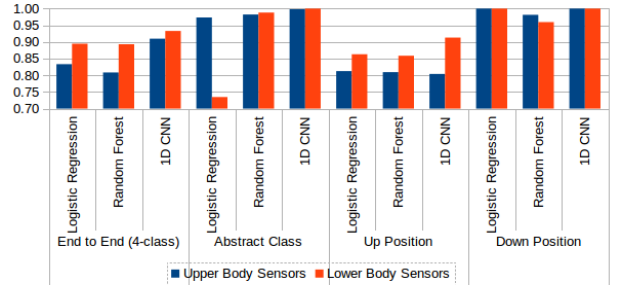
Figure 15. Comparison of upper body (blue) and lower body (red) sensor data performance without test data sharpening. Three machine learning techniques, logistic regression, random forest, and 1D CNN, are compared on 4-class and various 2-class problems.